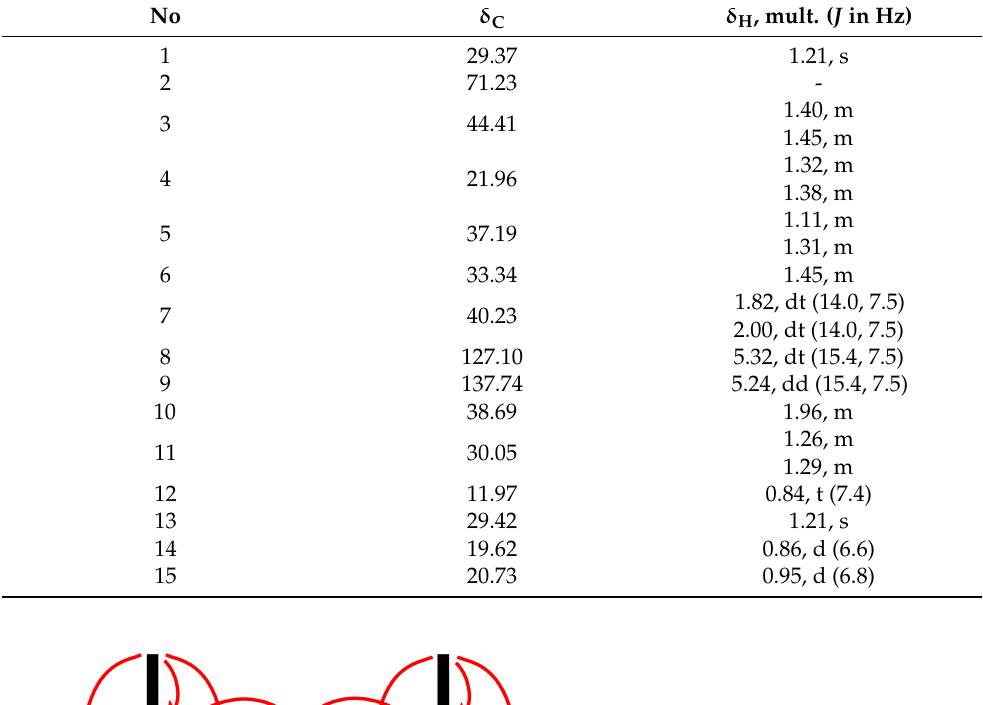
Table 1. 13 C NMR (125 MHz) and 1 H NMR (500 MHz) spectral data of 1 in CDCl 3 .